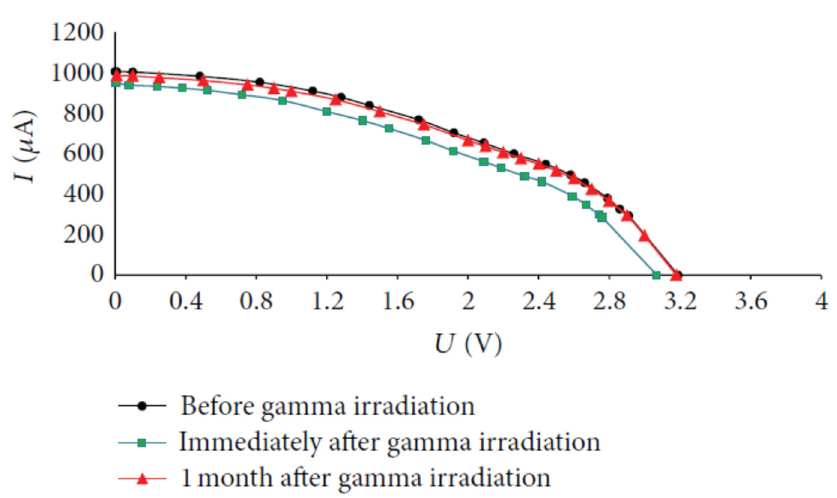
Figure 3. I ‐ V characteristics of the solar panels before and after gamma irradiation. Reproduced with permission from [117]. permission from